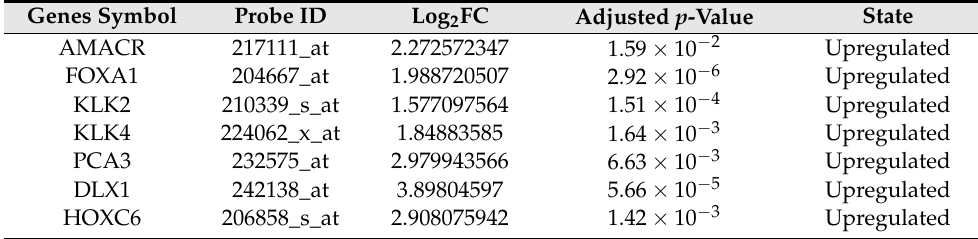
Figure 1. An overview of the preprocessing plots. The box plots show the expression value of the total of 30 samples before and after normalization. The ordinate reflects the gene expression values, while the abscissa displays the distinct samples. ( A ) The median gene expression values within each box (shown by the black line) were not equal before normalization. ( B ) The median of the expression values were nearly on the same line after normalizing, indicating satisfactory normalization performance. ( C ) The PCA plot for 30 samples. ( D ) The PCA plot for the 26 samples selected in this study (K400_PN, K815_PN, L083_PN, and K643_PC excluded). PCA, principal component analysis. Table 2. The previously known PCa biomarkers among our